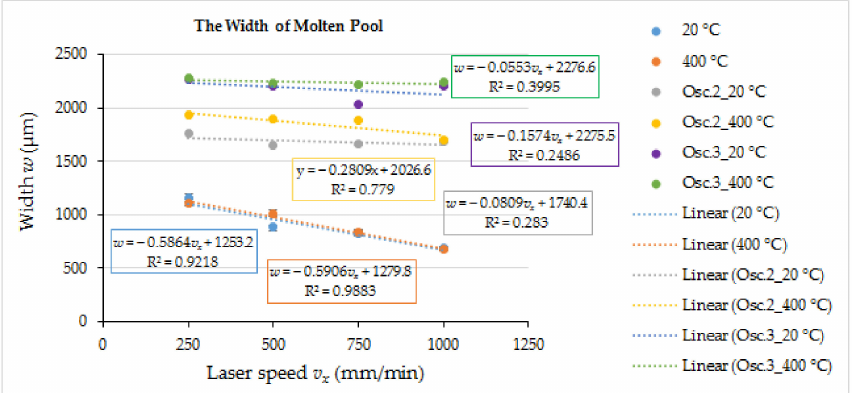
Figure 7. The relationship between the width of molten pool (measured in the widest part of the pool) and laser operating speed, applied oscillation amplitude and preheating temperature; oscillation amplitude A0—0 mm (no oscillation); oscillation amplitude A1—1 mm; oscillation amplitude A2—2